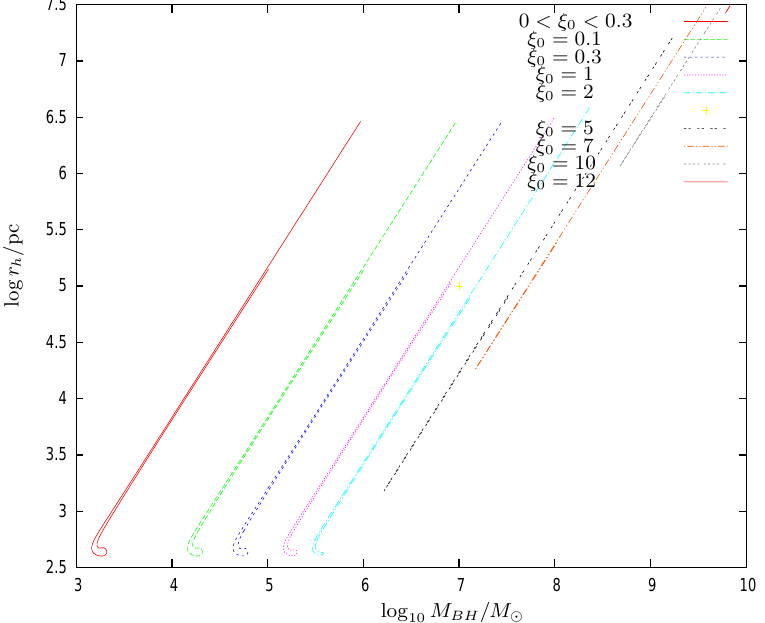
FIG. 12: The common logarithm of the halo radius log r h vs. the common logarithm of the central black hole mass log M BH for many galaxy solutions. The halo radius r h turns to be a double-valued function of M BH . Remarkably, r h scales with the black hole mass for fixed ξ 0 as r h = C ( ξ 0 ) M where the constant C ( ξ 0 ) is a decreasing function of ξ 0 .